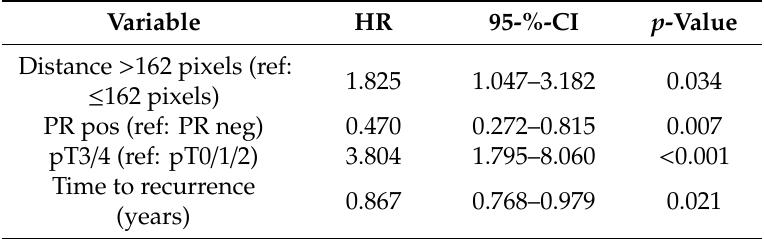
Table 5. Cox-regression